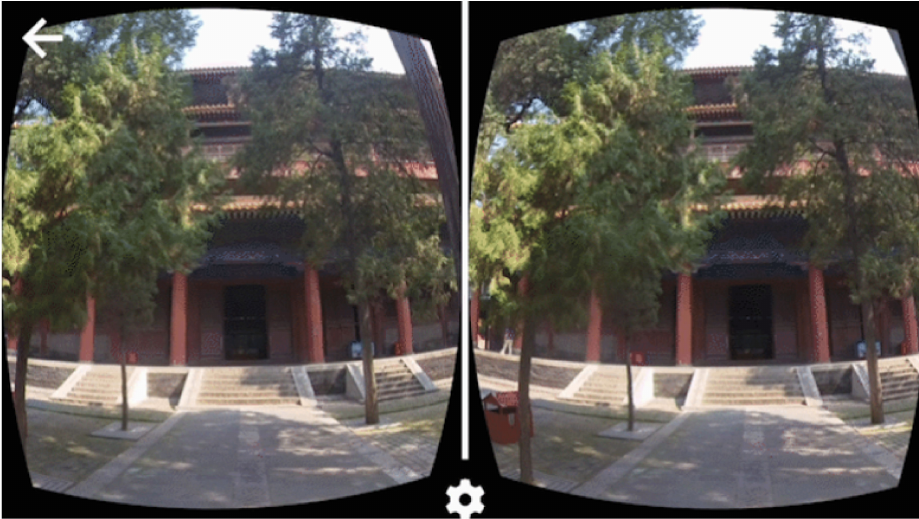
Figure 14. The 3D virtual tour on the